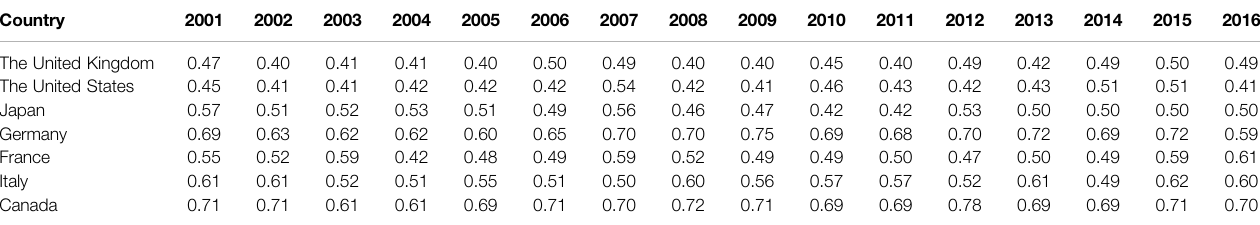
TABLE 4 | Sensitivity analysis of composite index score. Country